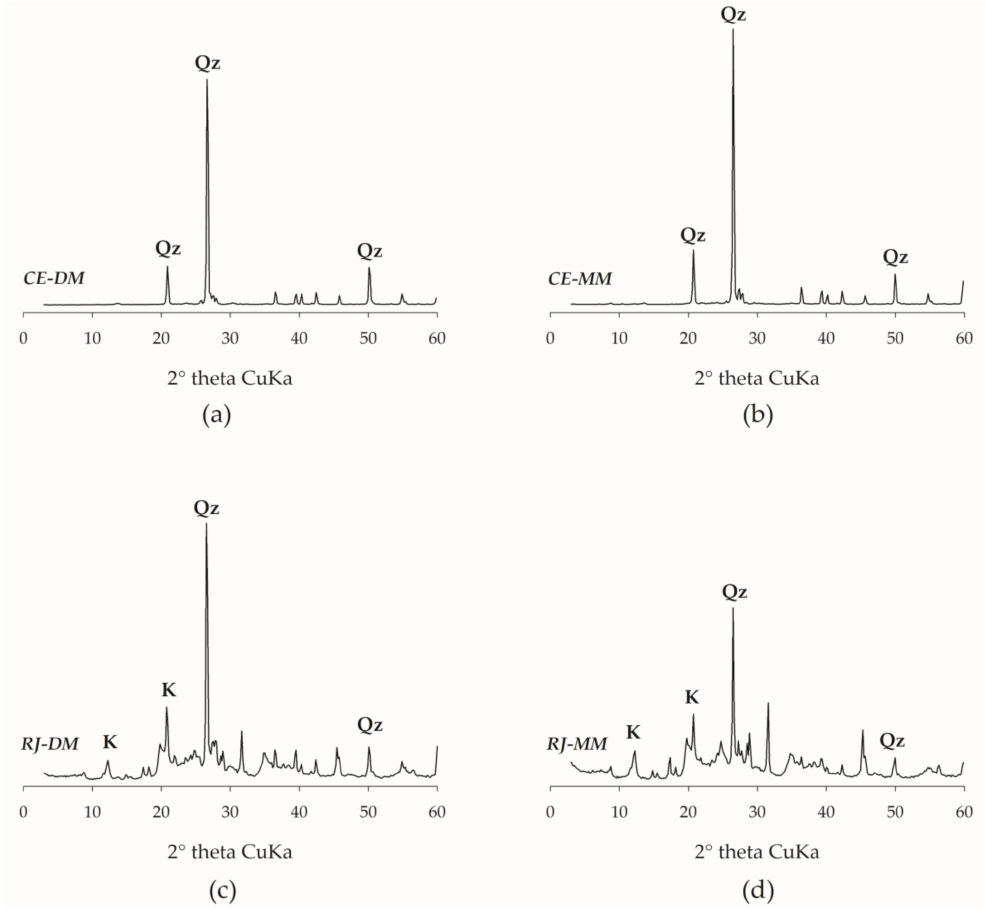
Figure 6. XRD data of nonoriented soil samples from both degraded and mature mangroves in the Cear á ( a , b ) and Rio de Janeiro ( c , d ) sites. Qz: quartz, K: